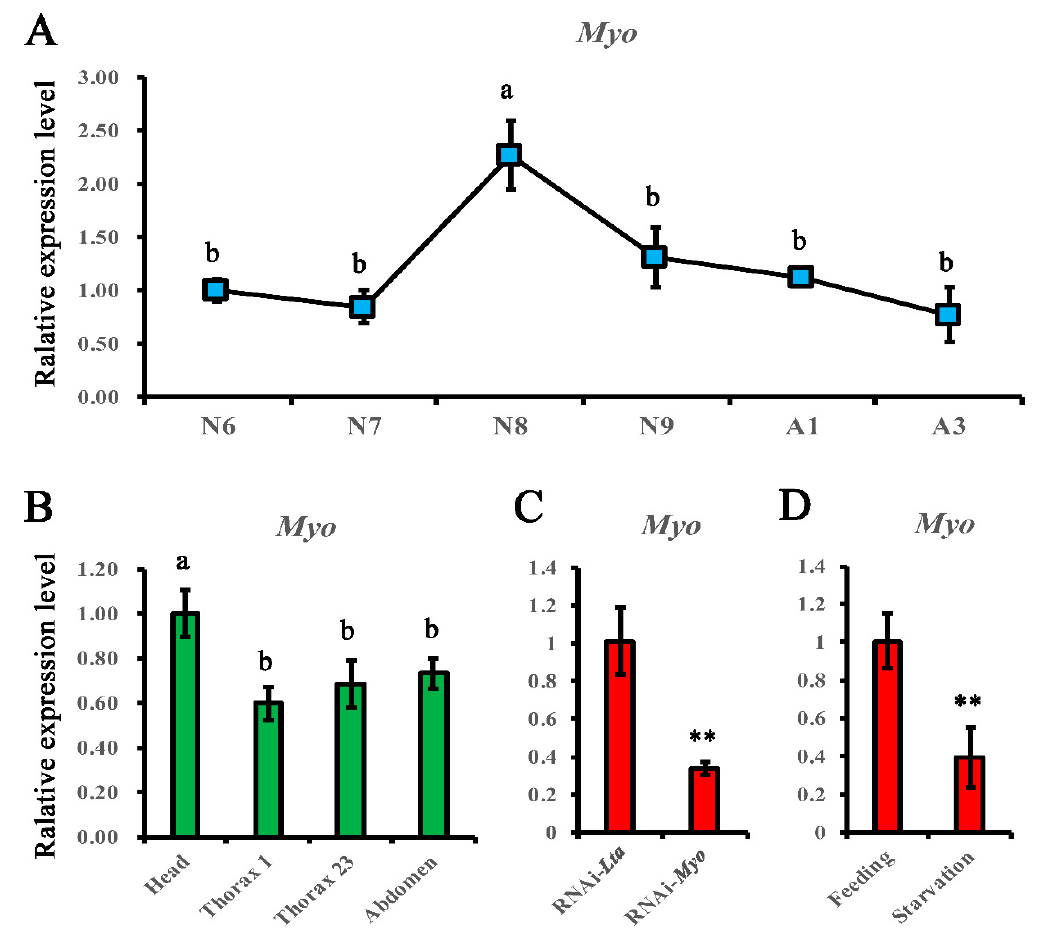
Figure 6. Relative expression levels of Tdmyo under various experimental conditions normalized with RPS26 and RPL32 . Error bars show the mean standard error calculated from three biological replicates. ( A ) In the head of T. domestica from the middle nymphs to adults. ( B ) In four body parts from individuals at the 8th nymphal instar. ( C ) In whole insects at the 8th nymphal instar under RNAi treatment. ( D ) In whole insects at the 8th nymphal instar under feeding or starvation conditions. Different letters (a, b) in ( A , B ) indicate significant differences of values (ANOVA, LSD, p < 0.05). The statistical level in ( C , D ) was assessed with ** p < 0.01.